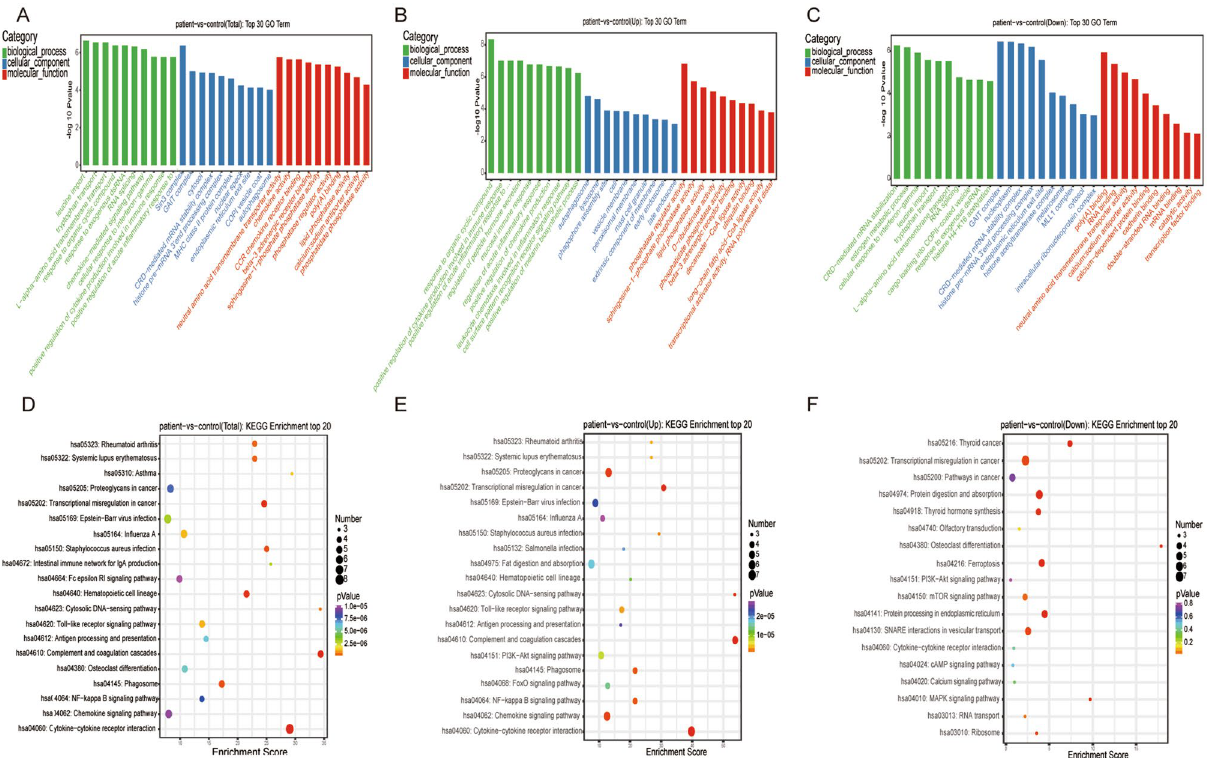
Figure 2. GO term and KEGG pathway enrichment analyses of DE-lncRNAs. ( A – C ) Top 30 enriched terms for all, upregulated, and downregulated genes. ( D – F ) Top 20 enriched terns for all, upregulated, and downregulated genes. The counts correspond to the numbers of the genes in a GO term or in a KEGG